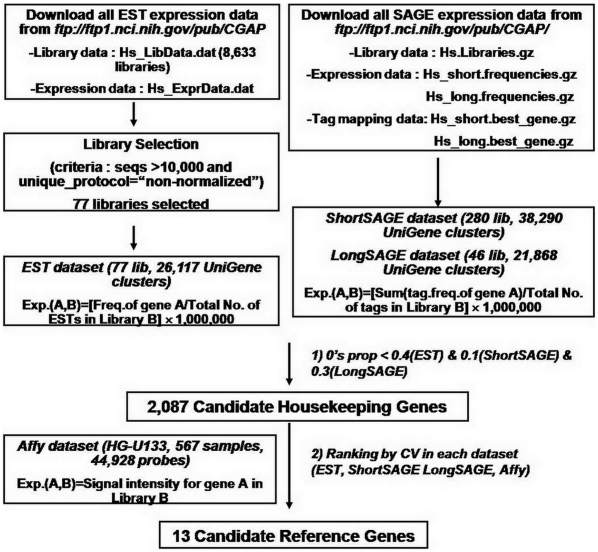
Flowchart of the methodology for identification of nERGs.2,087 candidate HKGs were first identified by selecting the genes meeting the following criteria: 0's prop <0.4 in EST, <0.1 in shortSAGE and <0.3 in longSAGE. 0's prop represents 0's proportion (number of tissues in which the gene is not expressed/total number of tissues, 0≤0's prop≤1). Among the candidate 2,087 HKGs, 13 nERGs with the lowest CVs were further identified by selecting the genes common to all four datasets among the genes with the 400 lowest CVs (approximately 20% of candidate HKGs).